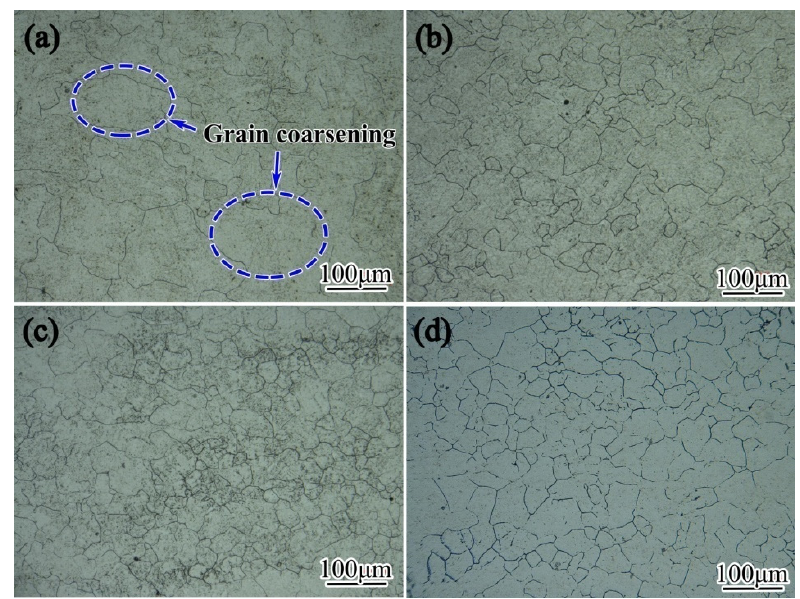
Figure 6. Microstructures of 300M steel compressed at 1150 °C and at ( a ) 0.01 s − 1 , ( b ) 0.1 s − 1 , ( c ) 1 s − 1 , and ( d ) 10 s − 1 .